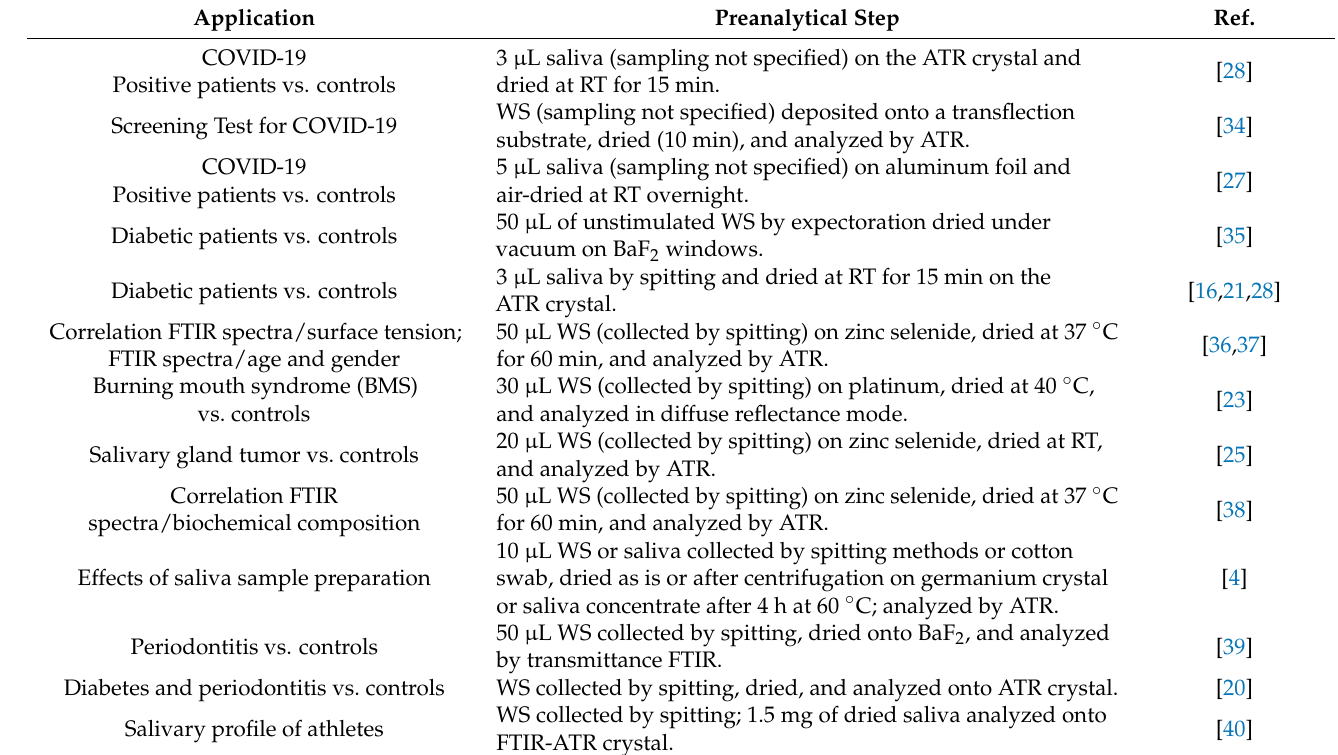
Table 1. Sample preparation for FTIR